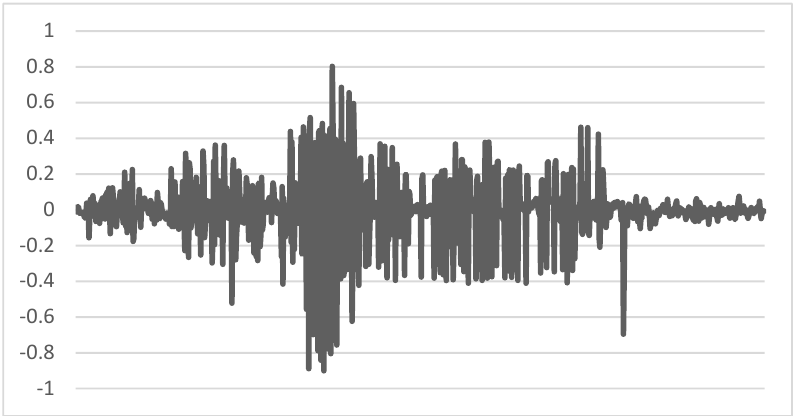
Figure 5. LOG (RETURN) residuals (authors calculation based on BSE stock prices).